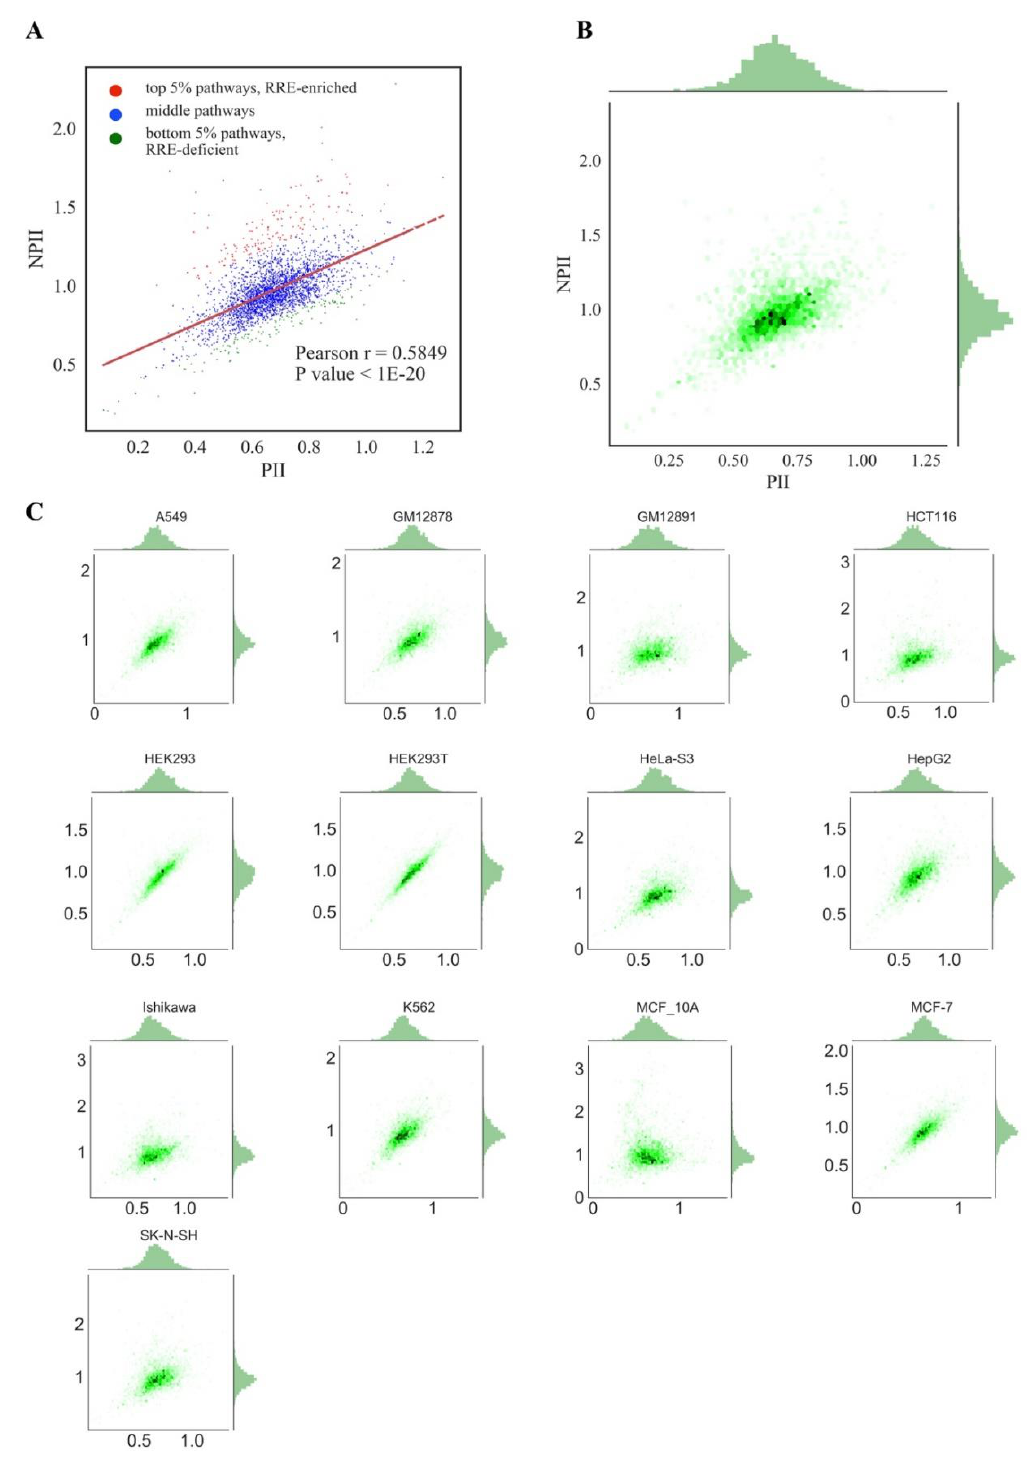
Figure 4. Comparison of PII and NPII scores across cell lines for all REs. ( A ) Comparison of mean PII and mean NPII scores. Each dot represents a single pathway; PII and NPII scores were averaged across all cell lines. Pathways enriched in RRE (regulation by retroelements) are shown as red dots. Pathways deficient in RRE are shown as green dots. ( B ) Comparison of mean PII and mean NPII scores. Both scores were averaged across cell lines. Color depth is proportional to the number of single dots (each dot represents a single pathway) in one grain. Univariate distributions of PII and NPII are shown in plot margins. ( C ) Comparison of PII and NPII scores for individual cell lines.